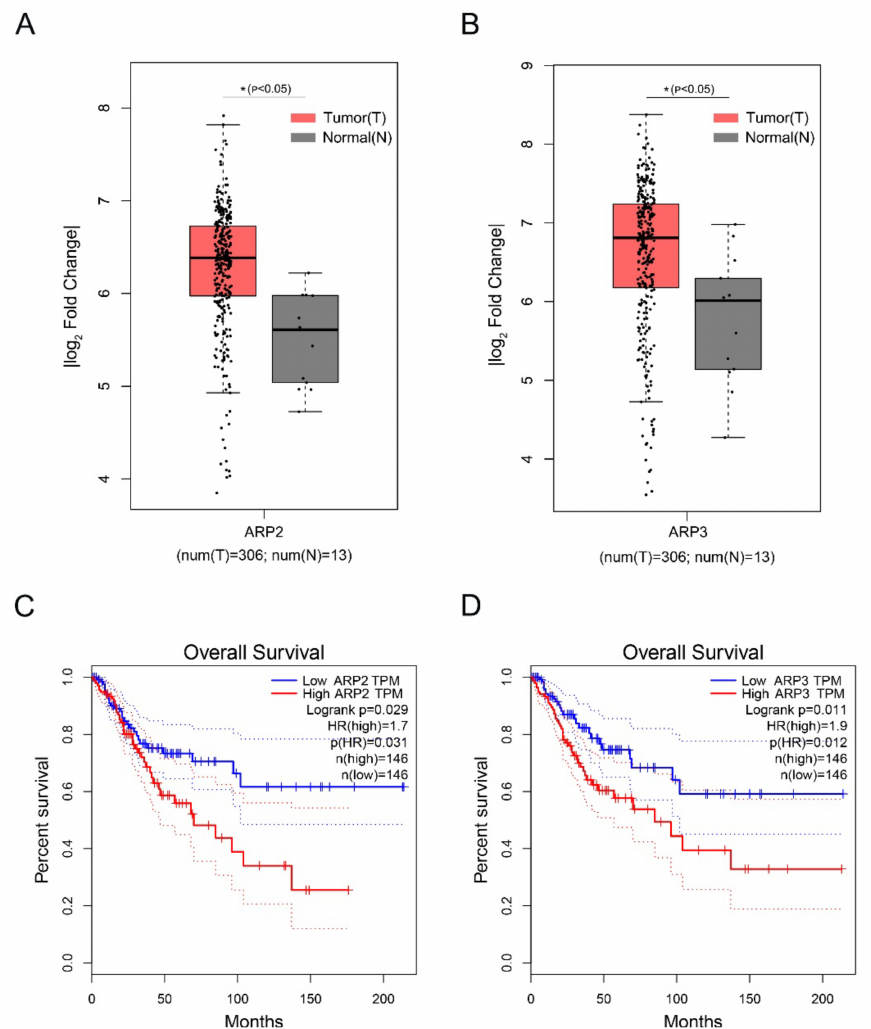
Figure 5. The high expression of ARP2 and ARP3 is associated with a poor prognosis of Cervical Squamous Cell Carcinoma. ( A , B ) Box plot of expression of ARP2 and ARP3 in CSCC. Gene expression analysis and survival analysis were performed by the GEPIA database. ( C , D ) The survival analysis of ARP2 and ARP3 in CSCC.